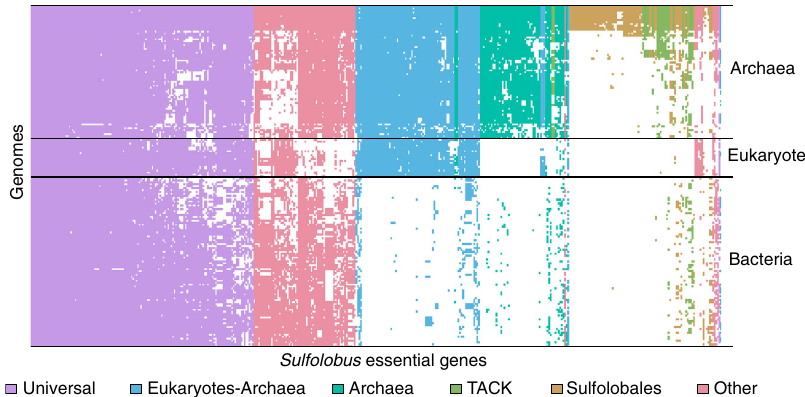
Fig. 6 Presence/absence of genes shows phyletic patterns. Heatmap of shared NOG/arNOGs according to annotations in the eggNOG database corresponding to the essential gene set of S. islandicus M.16.4 across the three domains of life. Each row is 1 of the 177 taxa including the set of 169 used for other distribution analyses, 1 from the candidate phylum Bathyarchaeota , and 7 Asgardarchaeota genomes (Supplementary Data 5 and 6). Each column is 1 of the 441 essential genes discovered in this study. A white box indicates that no matching NOG or arNOG was found, while a colored box indicates presence. Colors indicate categories de fi ned in Tables 1 and